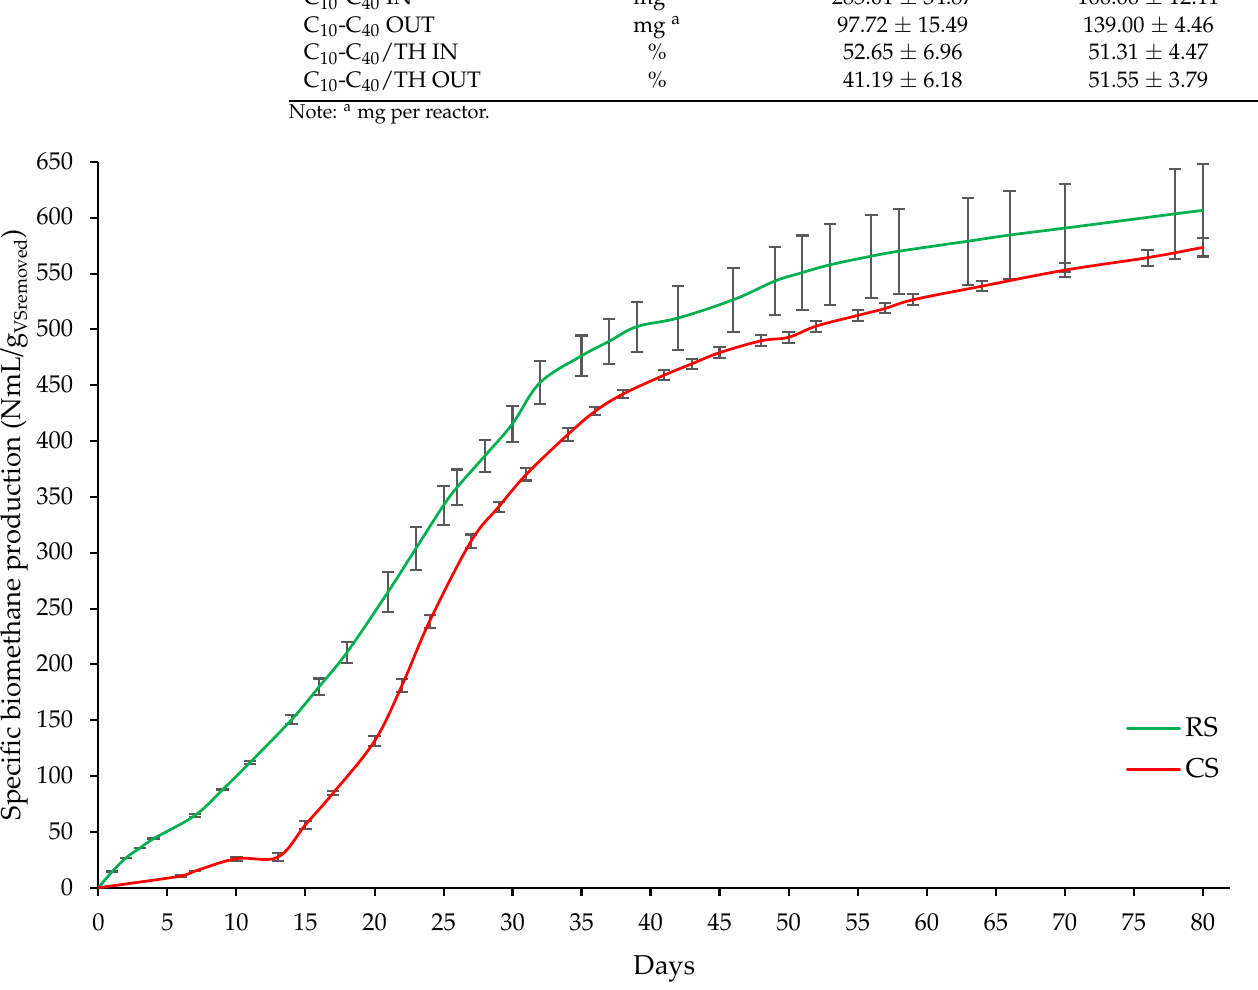
Figure 2. SBP during AD of CS (red line) and RS (green line).